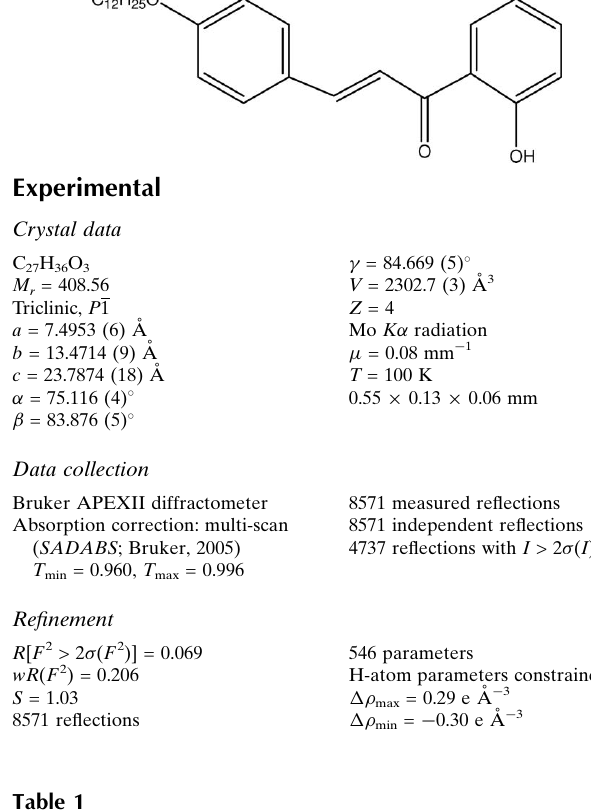
Hydrogen-bond geometry (A˚ , (cid:1)